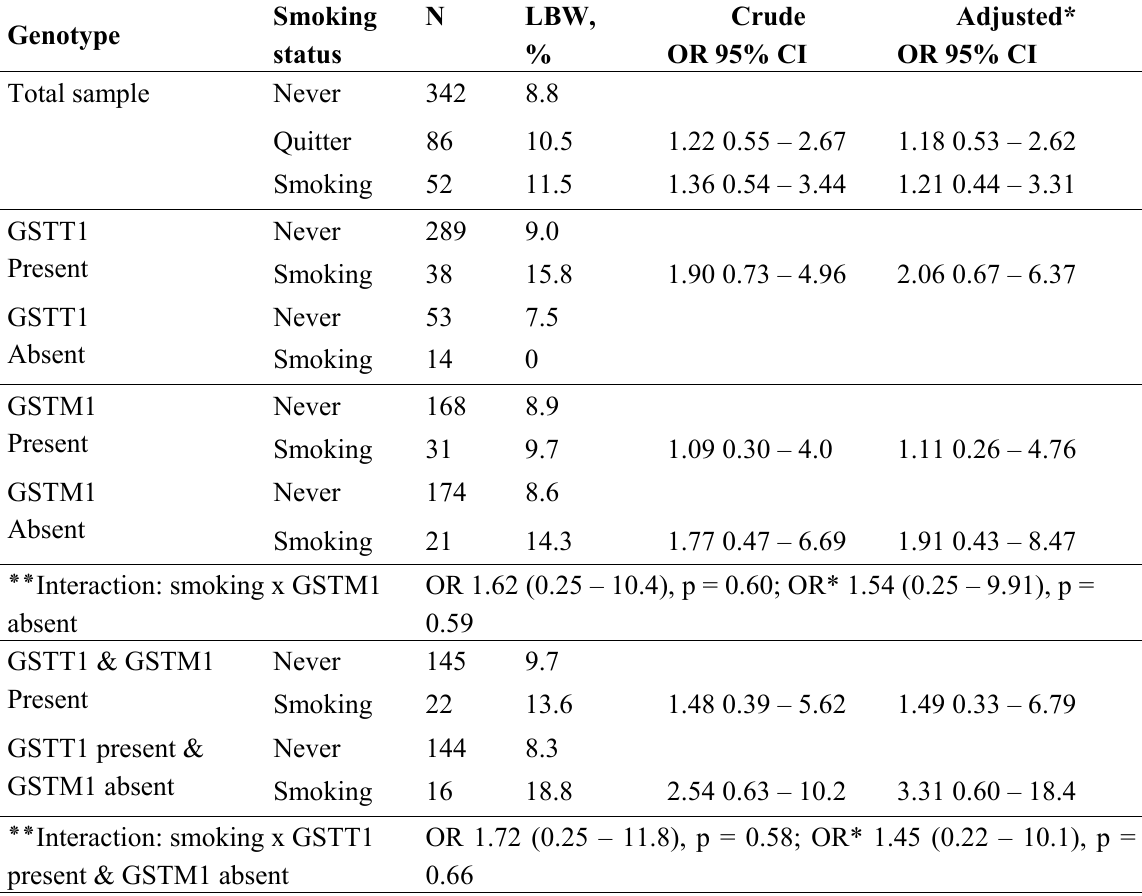
Table 3. Crude and adjusted associations as odds ratios (OR) maternal smoking during pregnancy with low birth weight by maternal